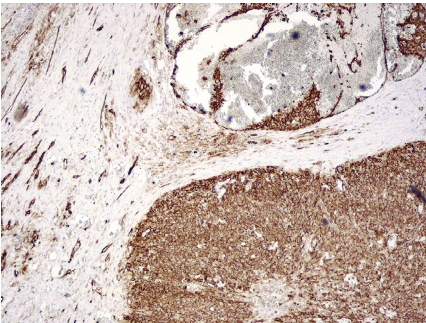
Figure 5: Immunohistochemical stain for CD34 highlights the malignant endothelial cells